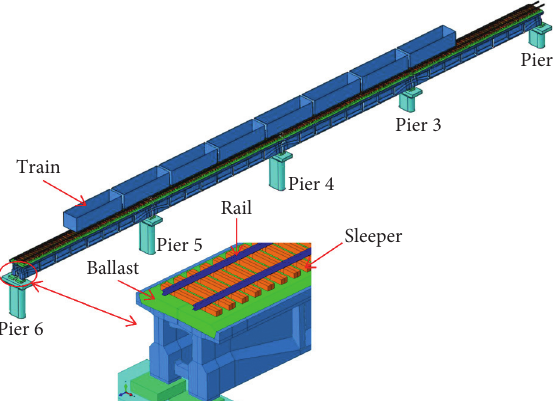
Figure 13: Three-dimensional coupled FE model of HHFTTB.